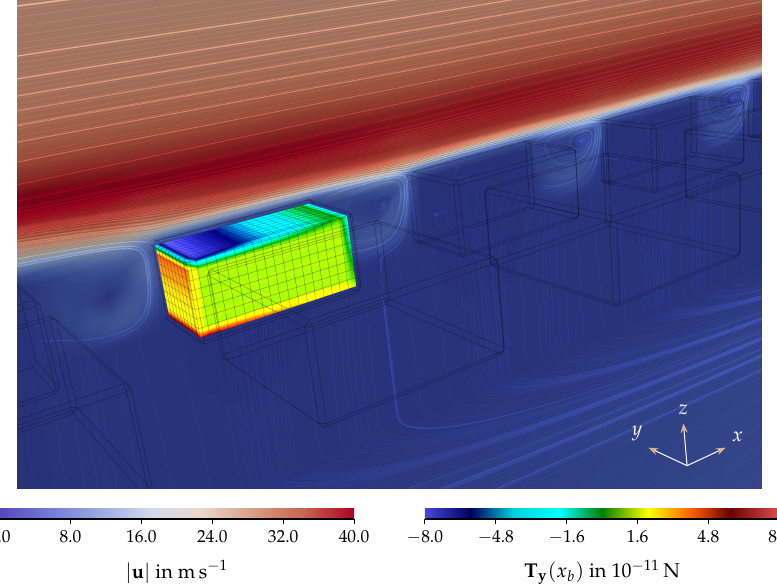
Figure 19. Detailed flow field with uniformly fragmented PM layer. Exemplary fragment coloured according to local contribution to torque T y ( x b ) . Streamlines exhibit local flow direction. Left colour scale indicates local flow velocity magnitude | u | . Porous substrate removed for visual